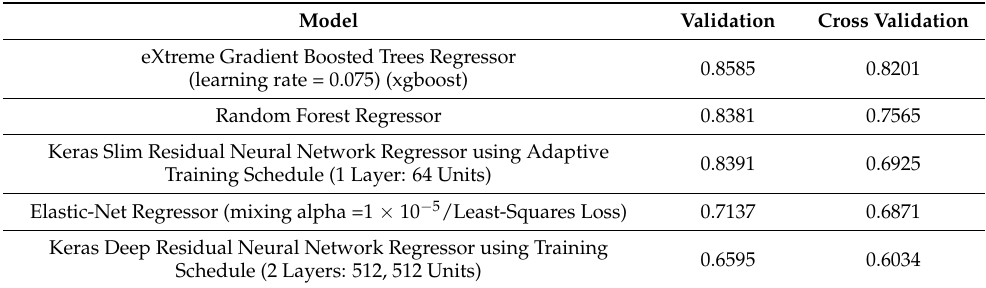
Table 4. Image prediction classification with supervised